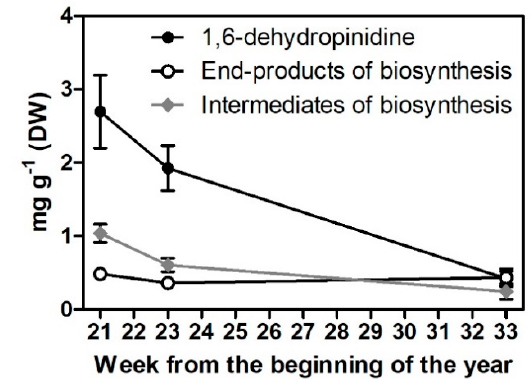
Concentration is reported as average ±SEM. GC-MS (gas-chromatography coupled with mass spectrometry) data are reanalyzed from Reference [20]. Statistically significant results of Tukey’s HSD (honestly significant difference) highlighted in bold.